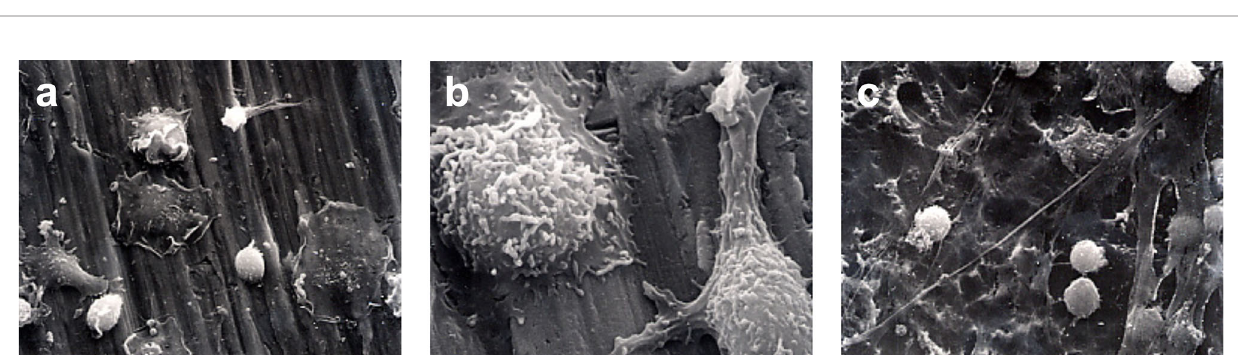
FIGURE 4 | Monocyte activation. SEM photomicrographs following 60-minutes incubation and immediately following stimulation with PMA. (A) 1250X magni fi cation of Group 1. Marked fl attening of cells and cell membrane spreading were observed. (B) 5000x magni fi cation of Group 4. Marked ruf fl ing of the monocyte cell membrane and pseudopodial extension was demonstrated. (C) 1250x magni fi cation of Group 5.